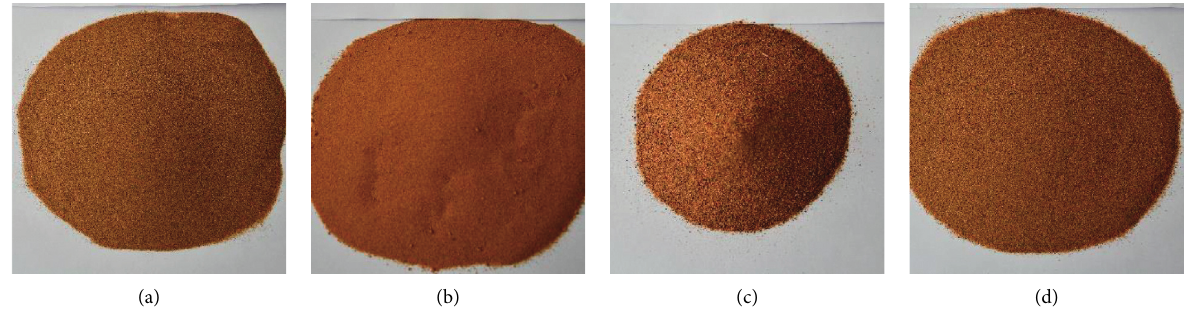
Figure 1: Four types of desert sand from different areas: (a) Kubuzi; (b) Maowusu; (c) Tengger; and (d) Ulanbuh.